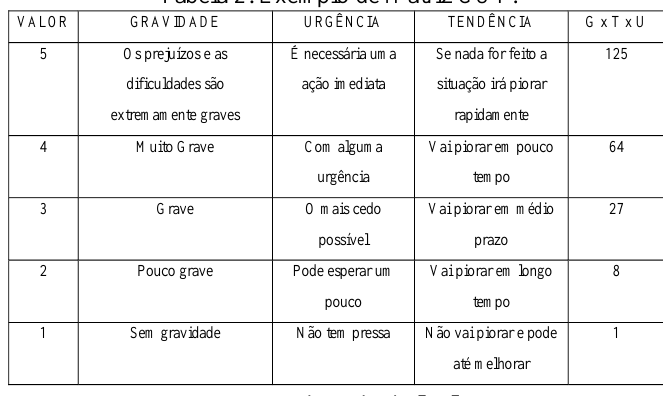
Tabela 2: Exemplo de Matriz